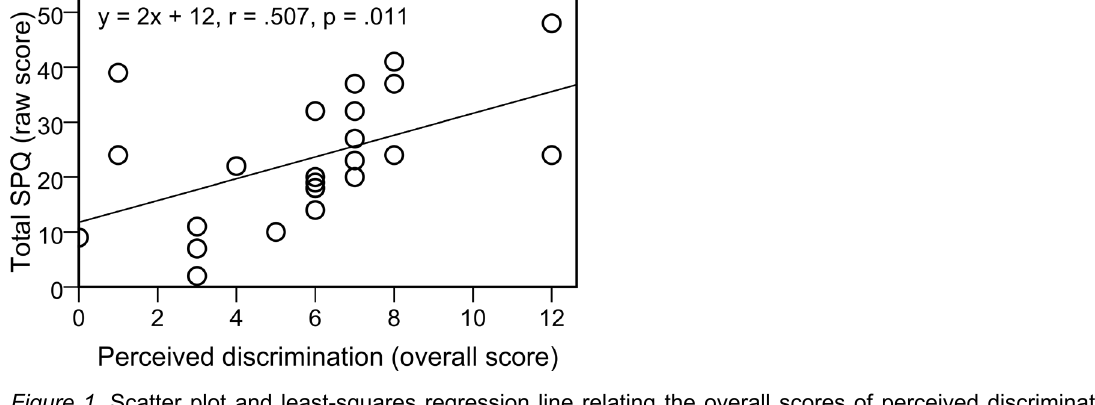
Figure 1. Scatter plot and least-squares regression line relating the overall scores of perceived discrimination to the total Schizotypy Personality Questionnaire (SPQ) scores observed among Moroccan migrants who had been classified by the presence of a family history of psychopathology ( n =